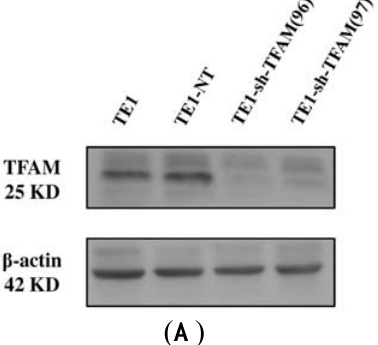
number of each cell line on day 1 was defined as